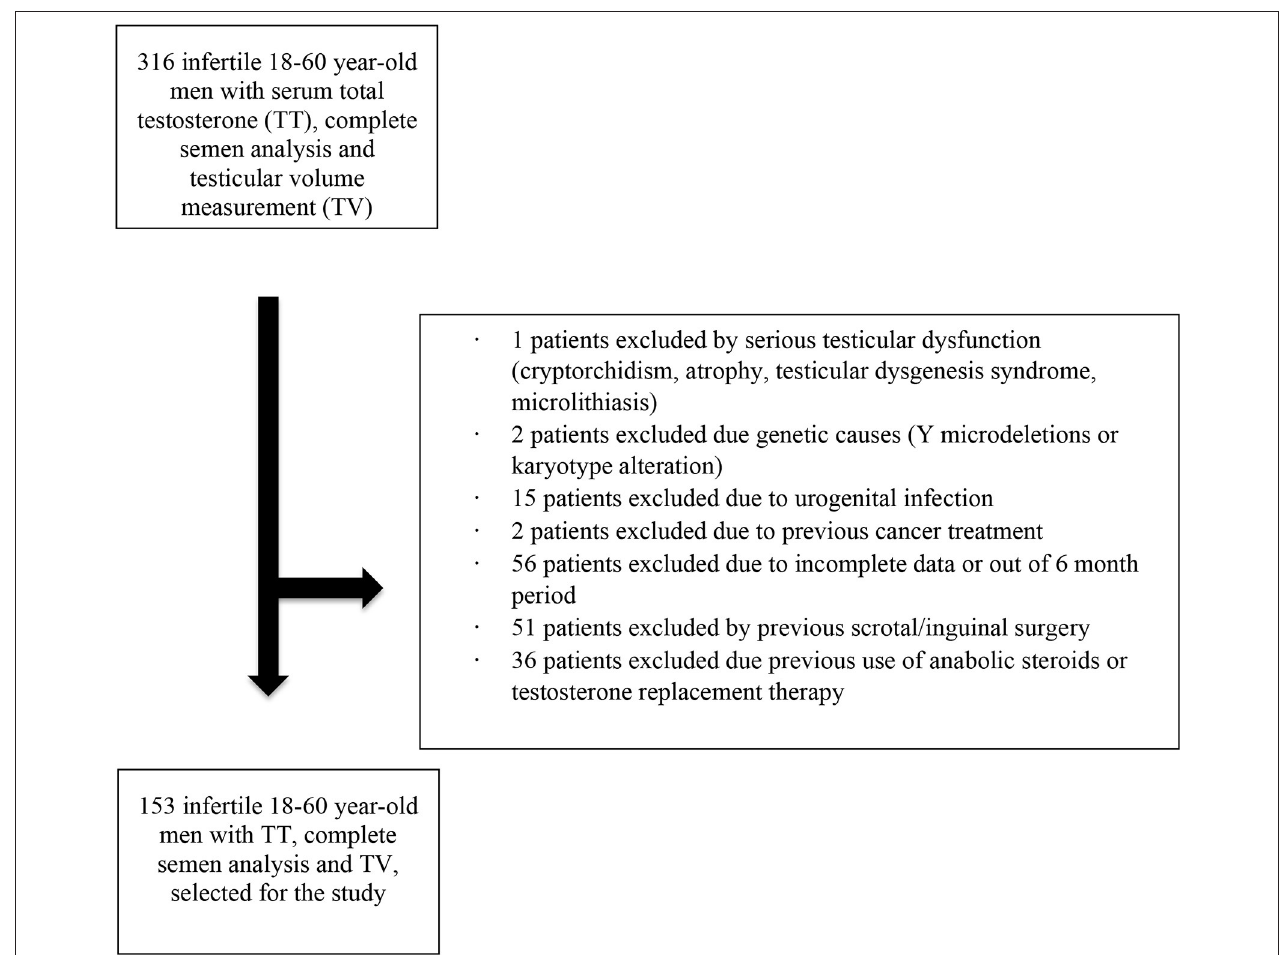
FIGURE 1 | Patient selection